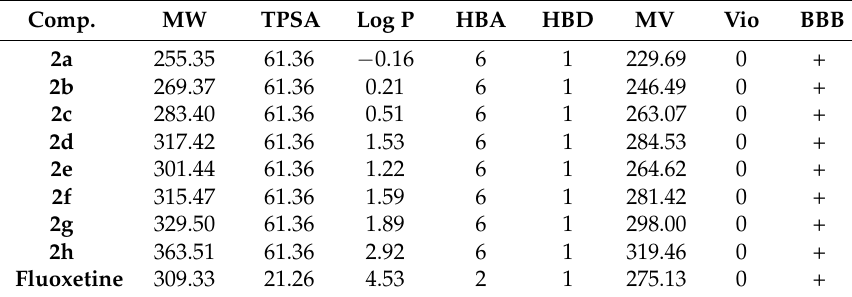
Table 1. Some physicochemical parameters used in prediction of absorption, distribution, metabolism, excretion (ADME) profiles of the compounds 2a – 2h and